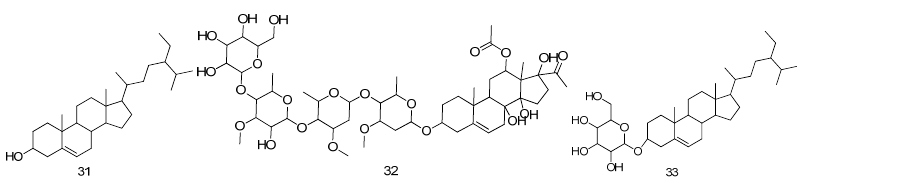
Table 4. The Glycerides identified from Fructus Malvae.